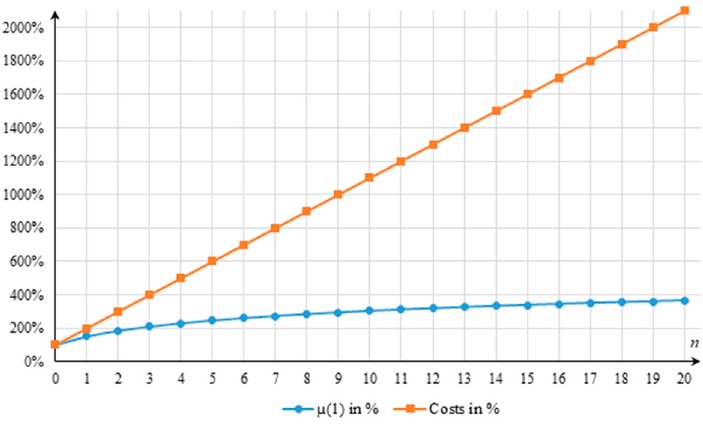
Figure 4. Increased time to system failure µ (1) related to increased cost associated with enlarging the system with more back-up systems.